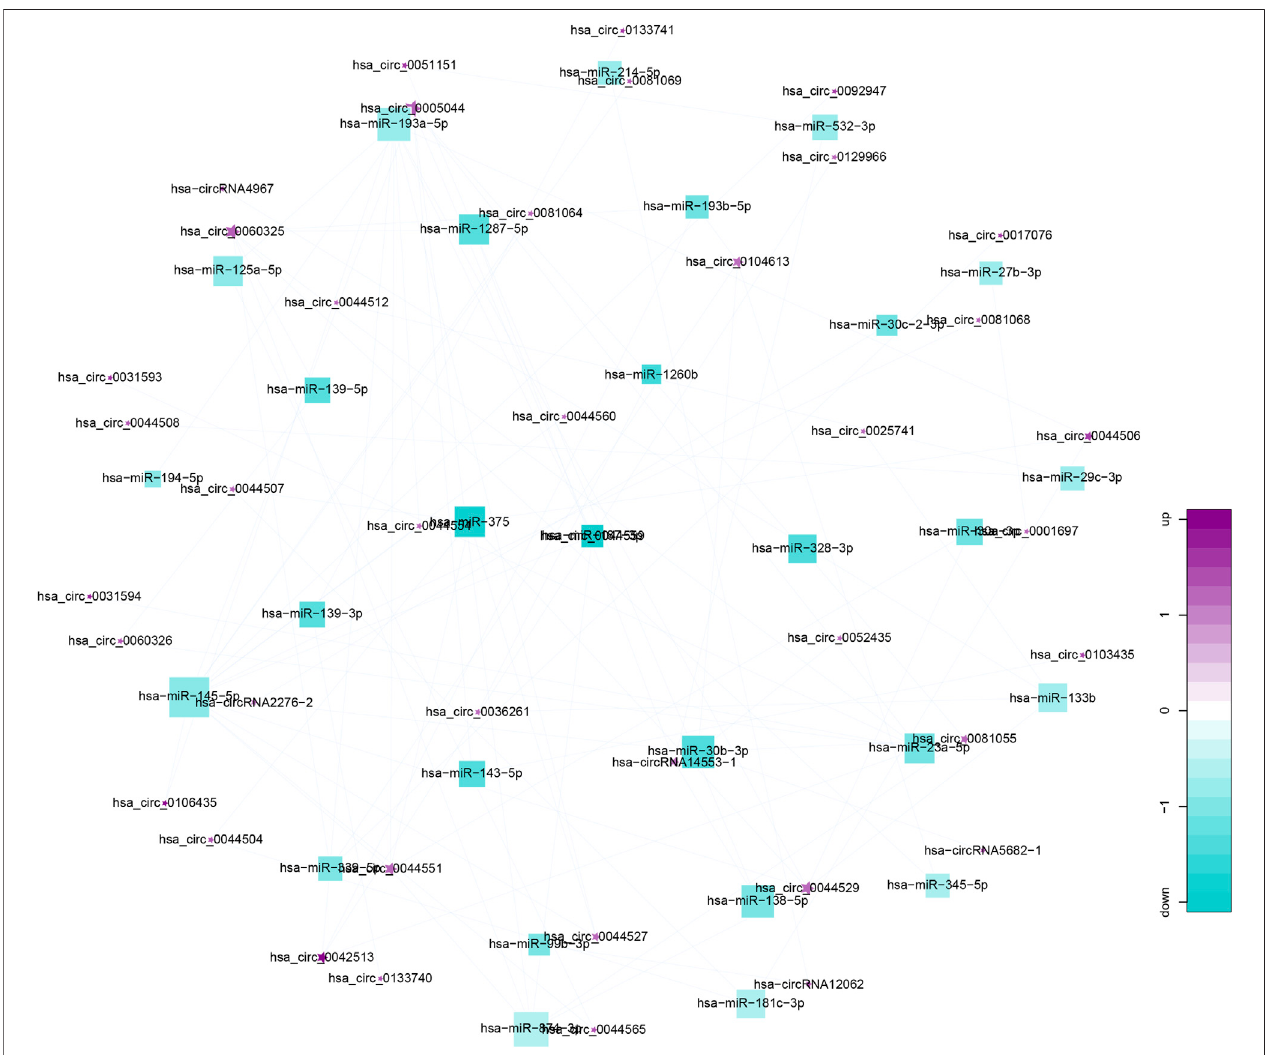
FIGURE 3 | Top 40 circRNA-miRNA co-expression networks. Co-expression networks were analyzed by miRanda-3.3 software, combined with entropy values below 20. Stars represent circRNAs; squares represent miRNA; lines represent correlative relationships. Different sizes and colors represent the corresponding (up/ down)